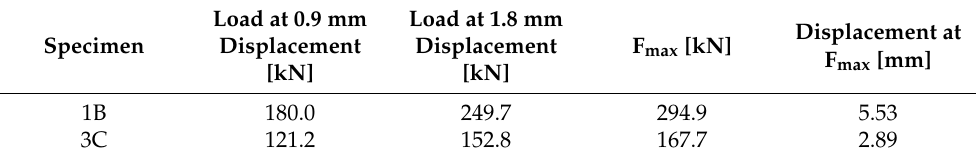
Table 1. Results of experimental measurements—specimens 1B and 3C.